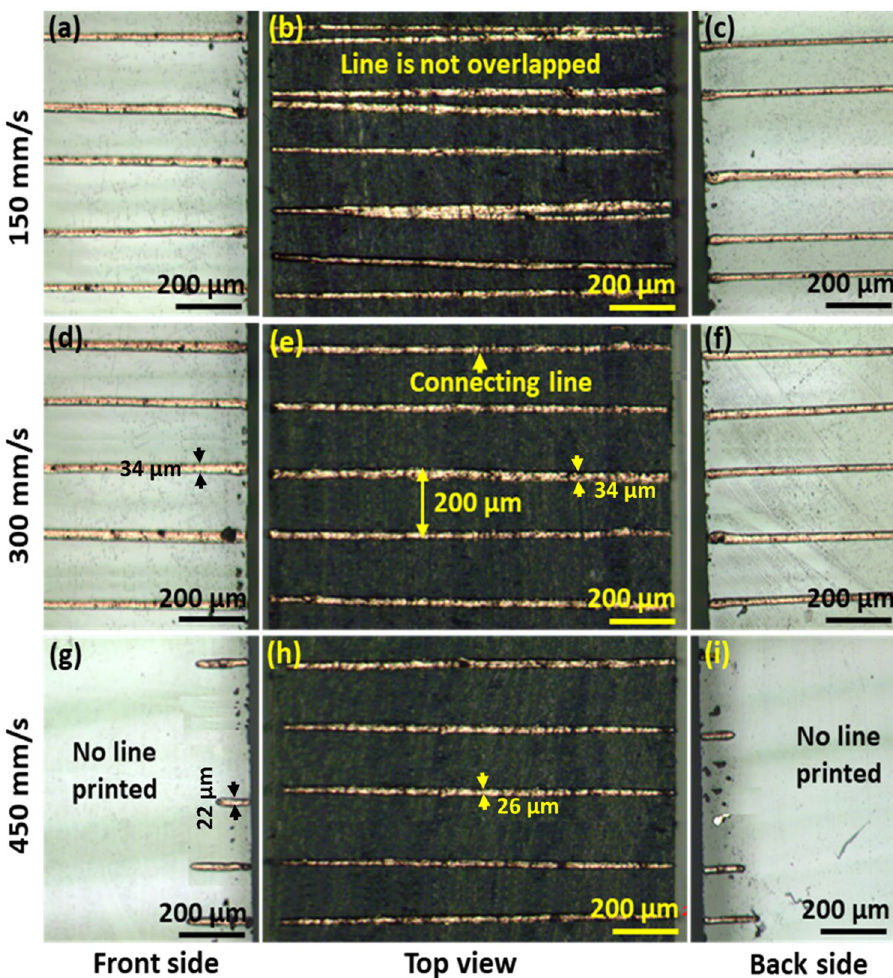
Figure 4. Optical microscopy images of Ag printed lines (printed line spacing of 200 μm) with respect to various printing speed. ( a – c ) at 150 mm/s; ( d – f ) at 300 mm/s; ( g – i ) at 450